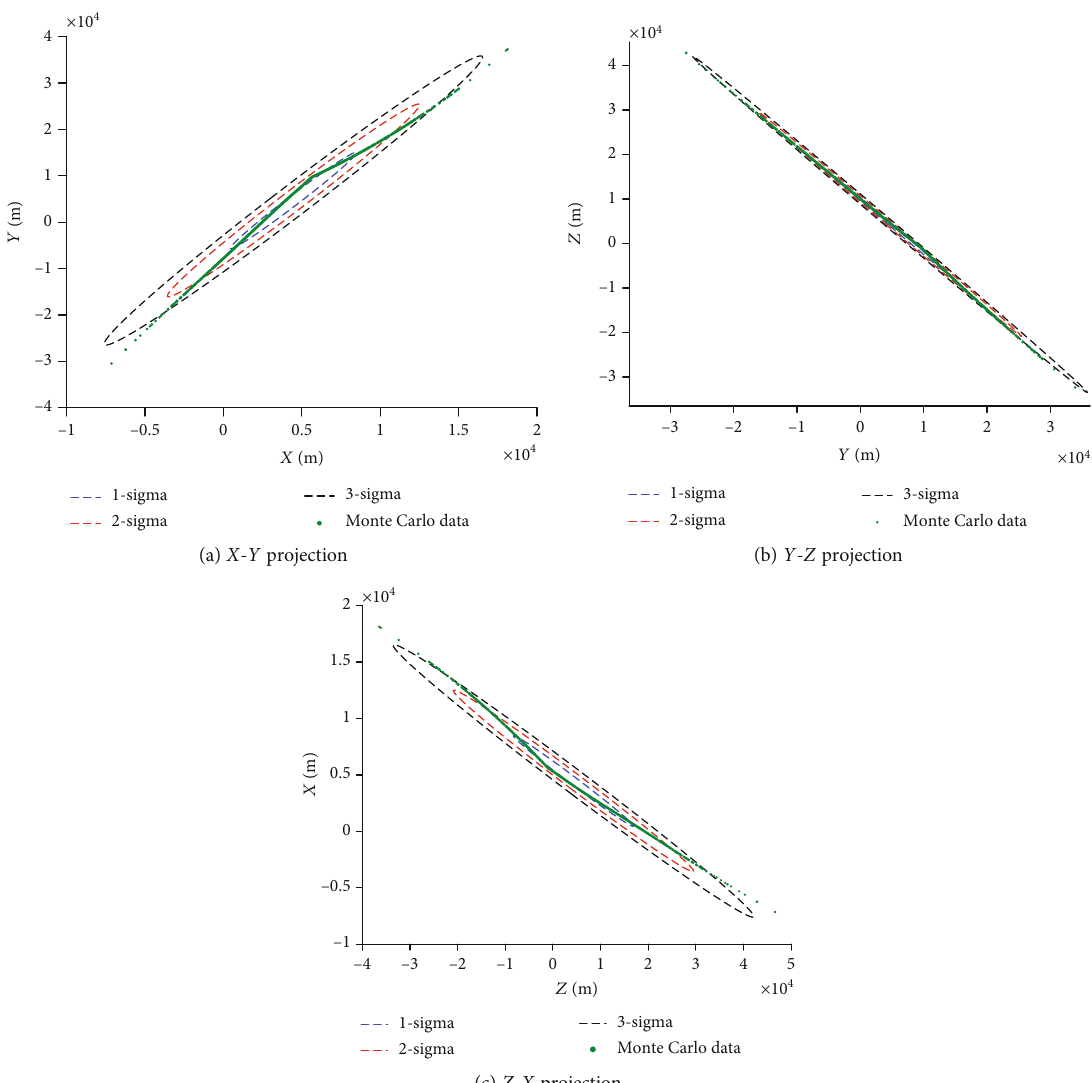
Figure 6: Error ellipsoid projection of Monte Carlo simulation results in the Earth model.